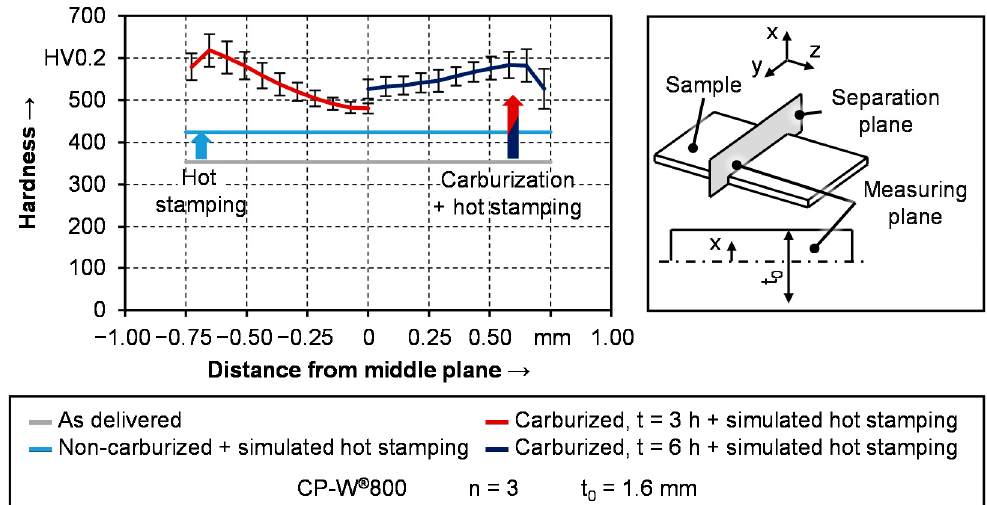
Figure 2. Hardness distribution in as-delivered condition as well as after hot stamping.